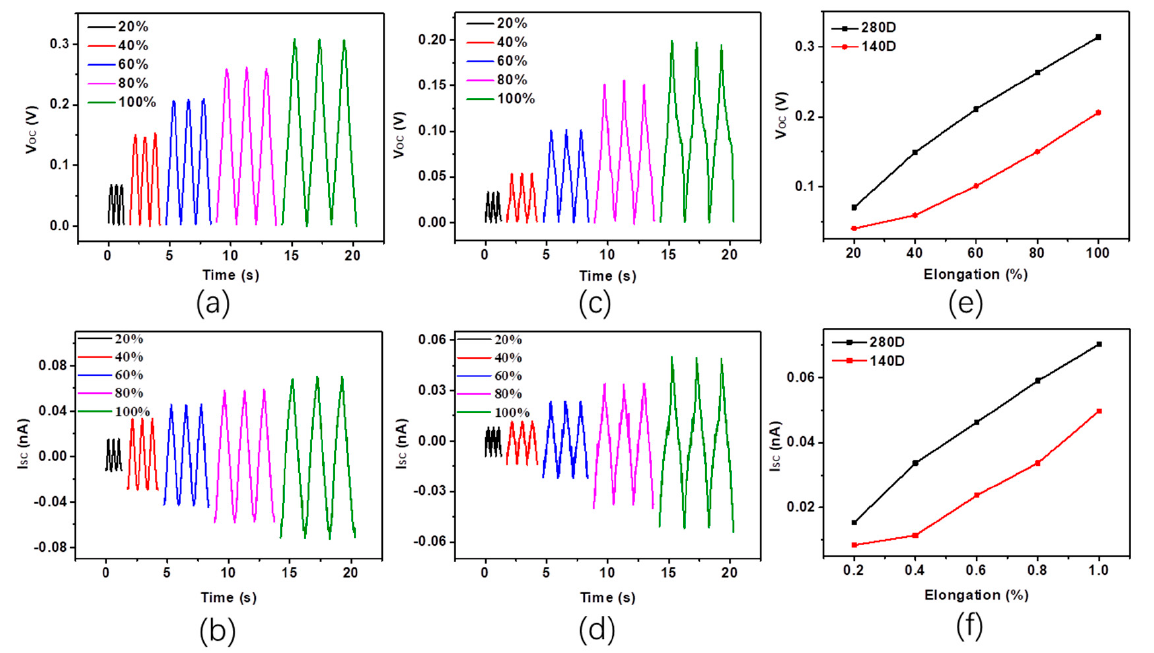
Figure 4. ( a , b ) Electrical output performances of the 3DWE-TENG fabricated with 280D PA con- ductive yarn; ( c , d ) Electrical output performances of the 3DWE-TENG fabricated with 140D PA conductive yarn; ( e , f ) Electrical output performance comparison between two 3DWE-TENGs fabri- cated with 280D and 140D PA conductive yarn.